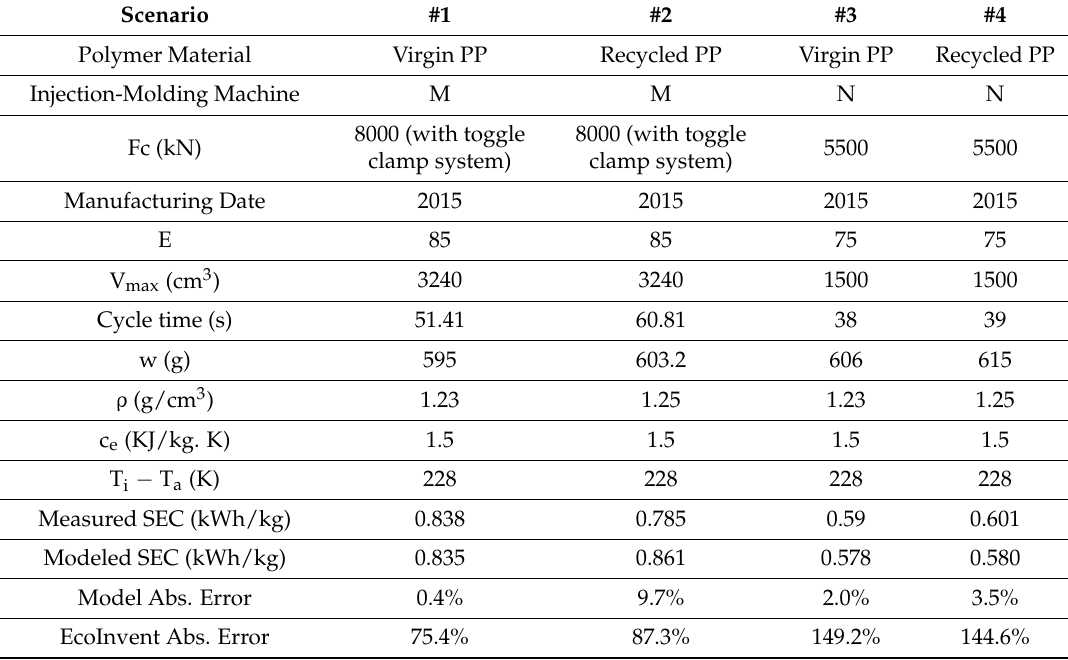
Table 3. Case study data summary.